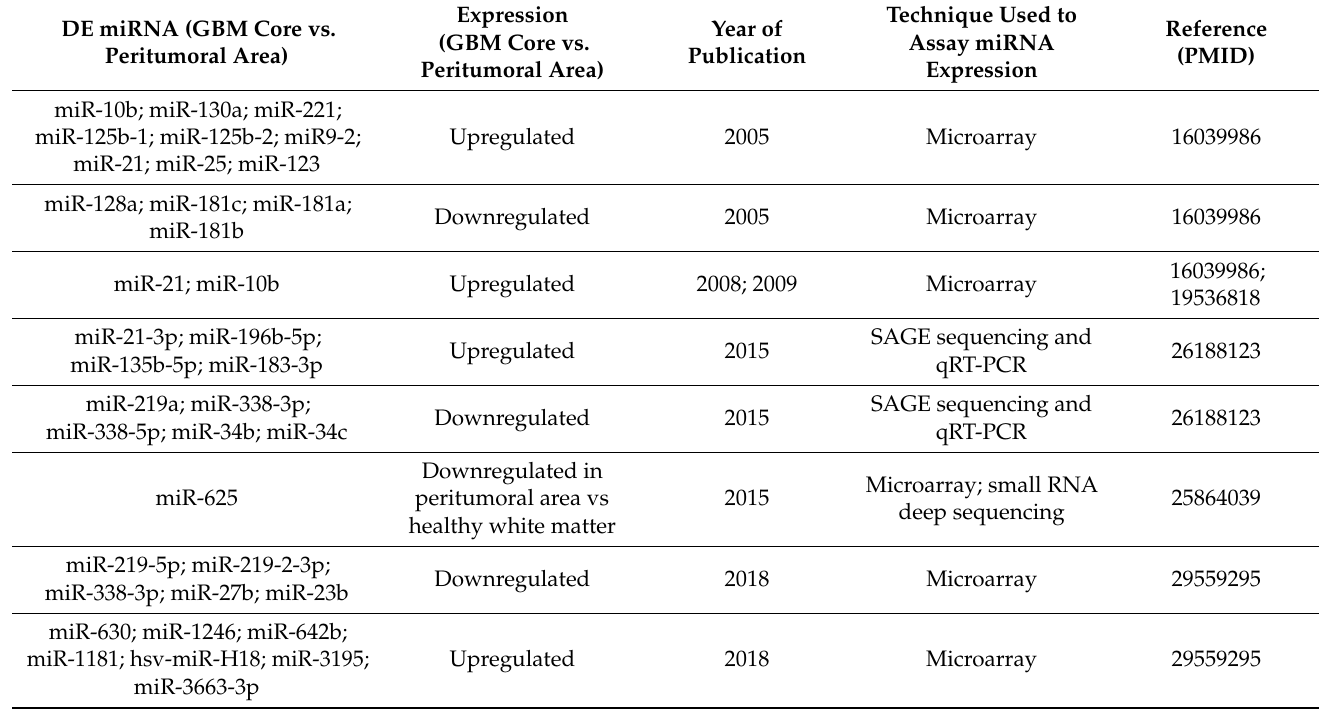
Table 1. Summary of miRNAs differentially expressed (DE) between GBM core and peritumoral area. DE miRNA (GBM Core vs. Peritumoral